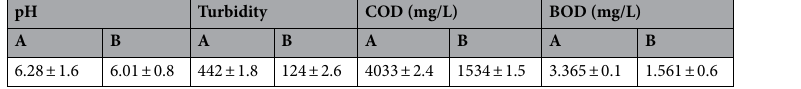
Table 6. Application of bioflocculant produced by B. velezensis in brewery wastewater treatment. The values are expressed as means ± standard deviation of triplicate determinations. A: before treatment, B: after